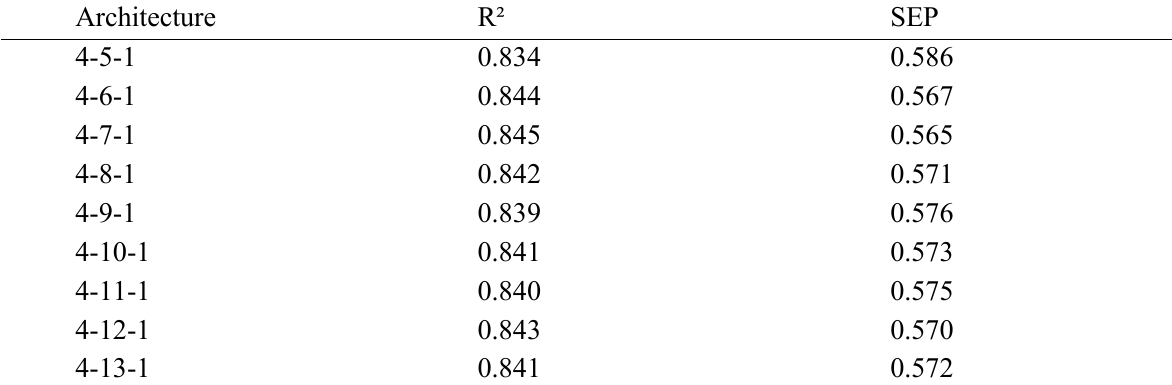
Table 2. Leave-one-out R² and standard error of prediction (SEP) obtained by NN trained with 82 data points.